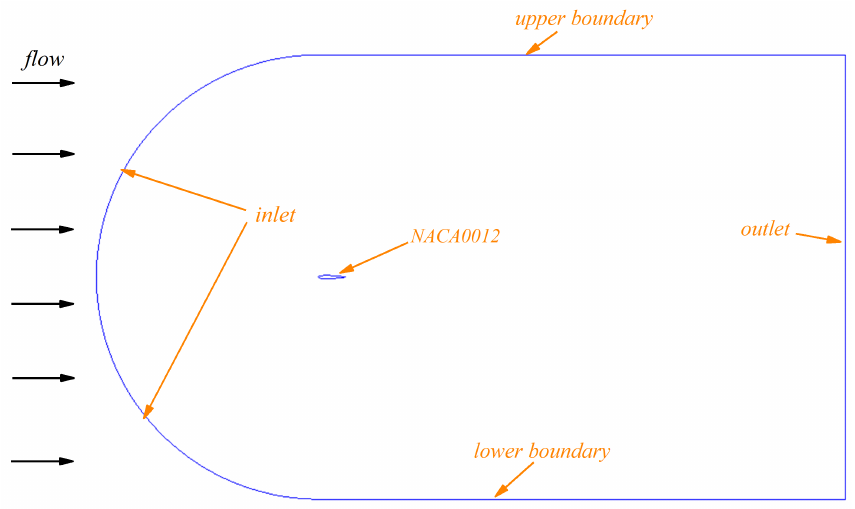
Figure 1. General layout of the computational domain. Arrows indicate location of the inlet and outlet of the computational domain.